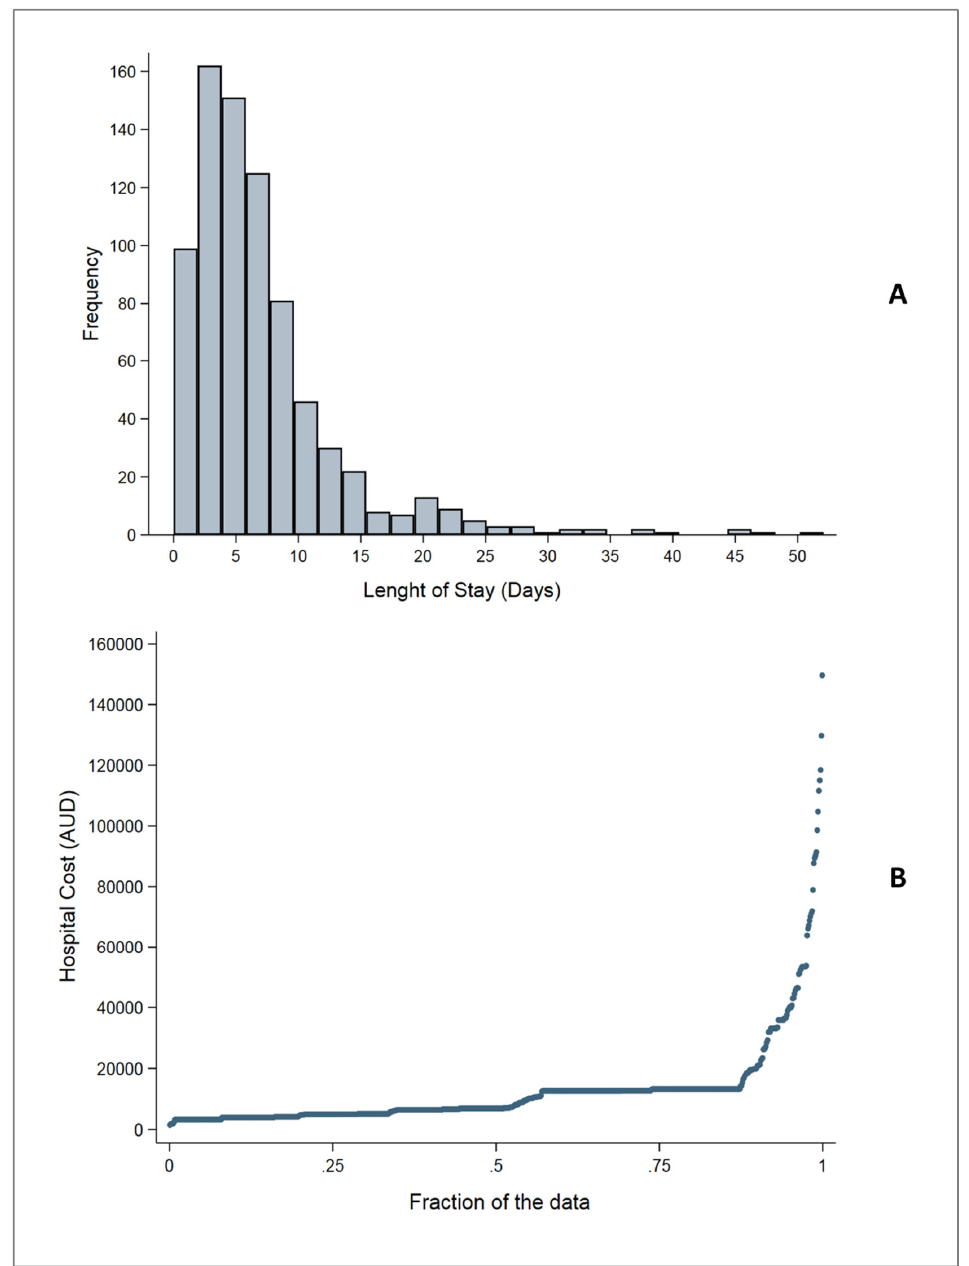
Figure 1. ( A ) Histogram depicting the distribution of LOS; and ( B ) quantile distribution of hospital costs among the study population of older adults hospitalised for acute stroke.